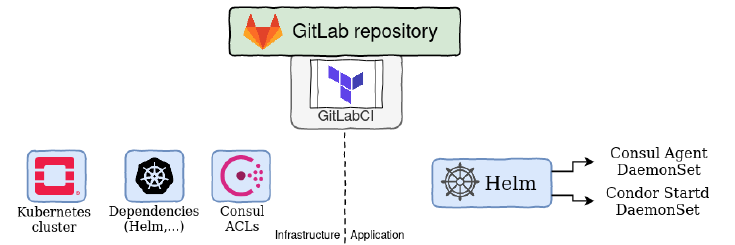
Figure 2. Terraform providers involved in cluster